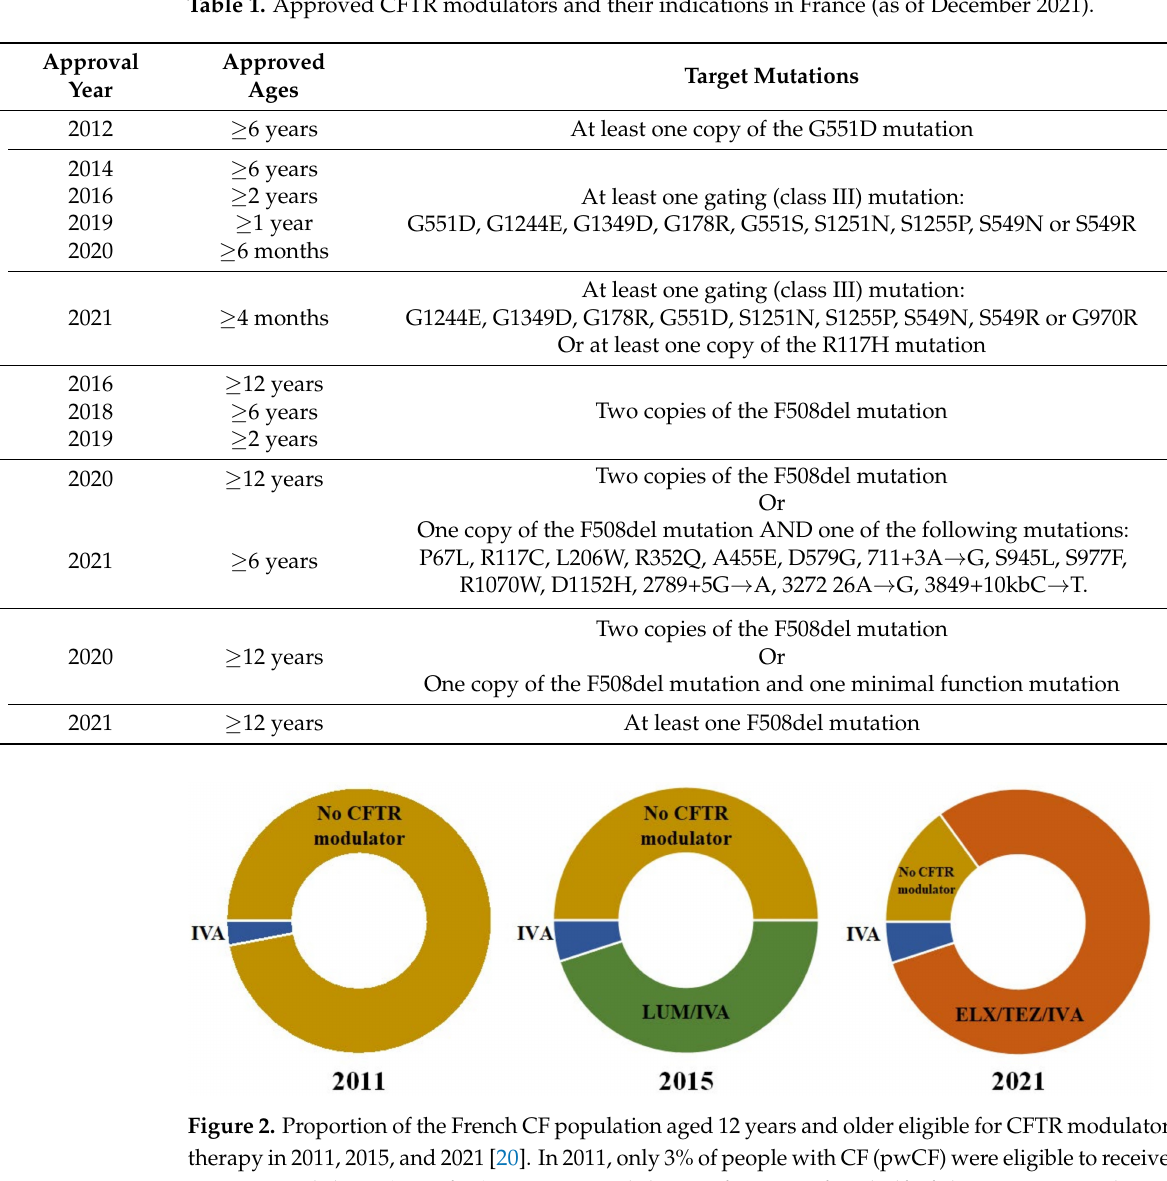
Table 1. Approved CFTR modulators and their indications in France (as of December 2021).